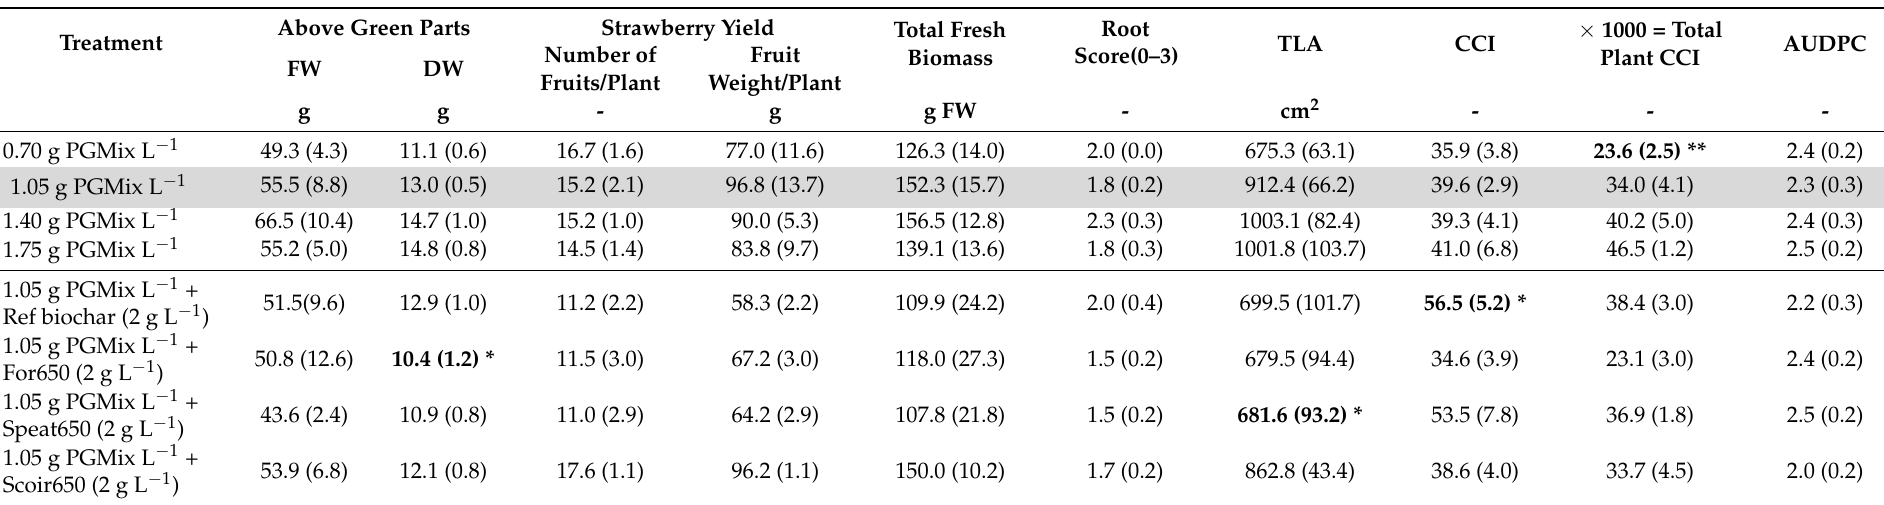
Table 5. Plant data of the strawberry pot trial (DW = dry weight, FW = fresh weight, TLA = total leaf area, CCI = Chlorophyll Concentration Index (average) and the AUDPC (Area Under the Disease Progress Curve) of 6 replicates with standard error in parentheses (values in bold are statistically different from the reference fertilizer dose (in grey: 1.05g PGMix L − 1 ) with *: p < 0.05; **: p < 0.01). Codes for biochar: See Table 1, ref biochar: Reference biochar based on stone oak wood, PGMix: Multi-mix Potting Soil 14+16+18 mineral